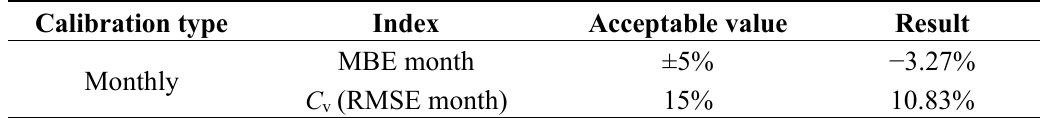
Table 9. Simulation validation